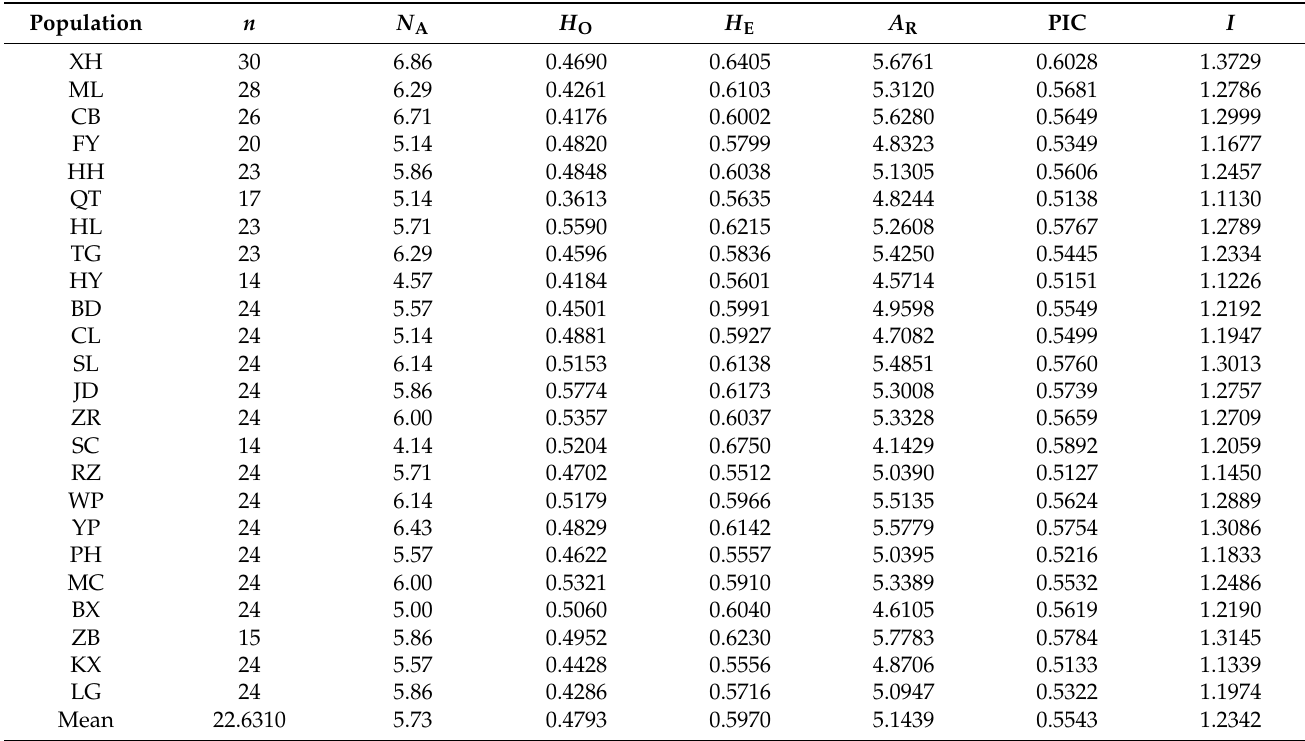
Table 2. Genetic diversity in the 24 populations of S. litura .